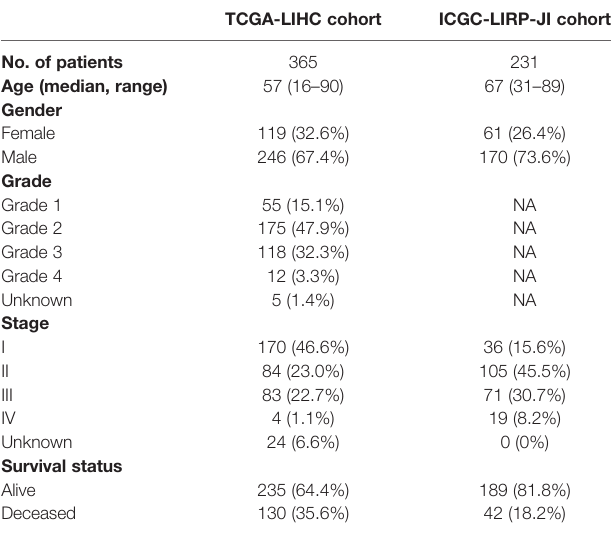
TABLE 1 | Clinical characteristics of the HCC patients used in this study.